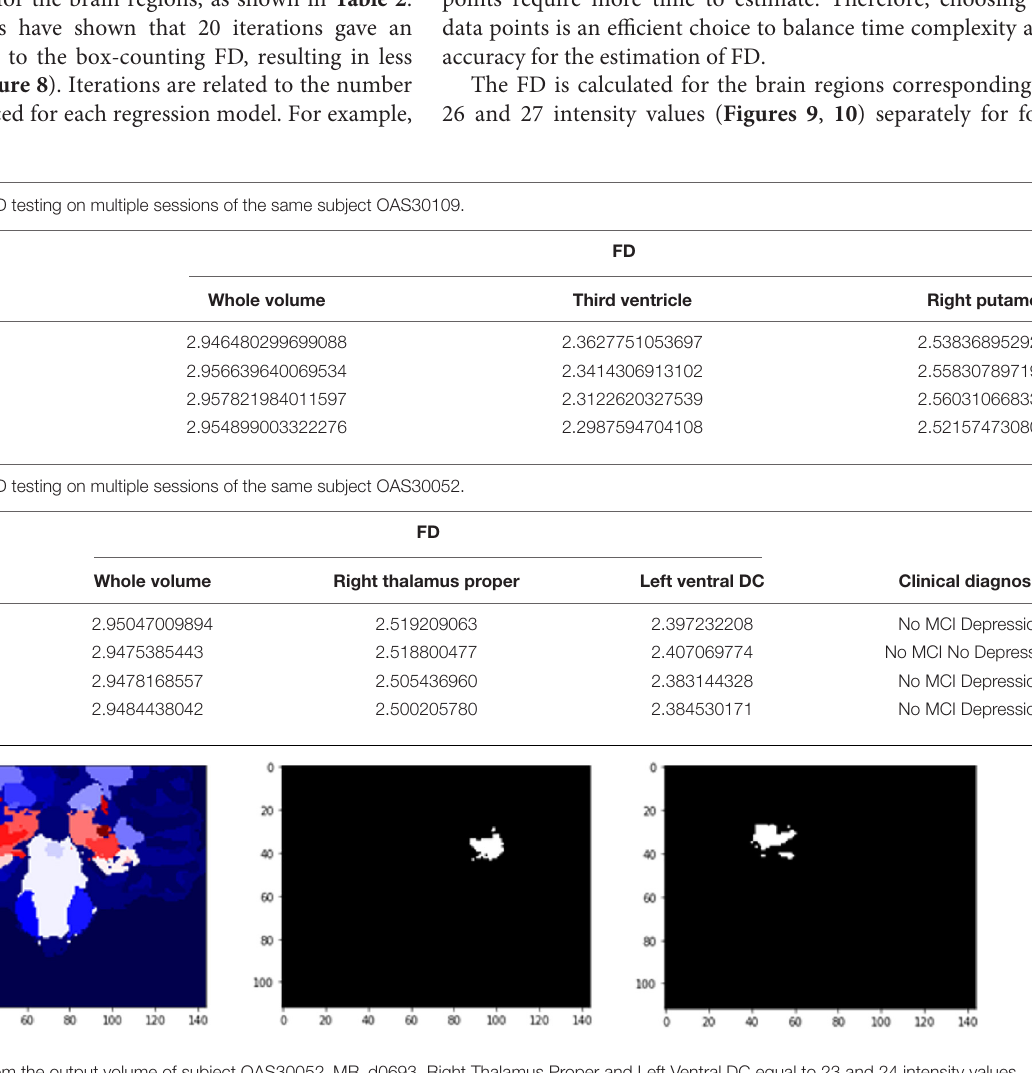
FIGURE 11 | 2D scan from the output volume of subject OAS30052_MR_d0693. Right Thalamus Proper and Left Ventral DC equal to 23 and 24 intensity values.